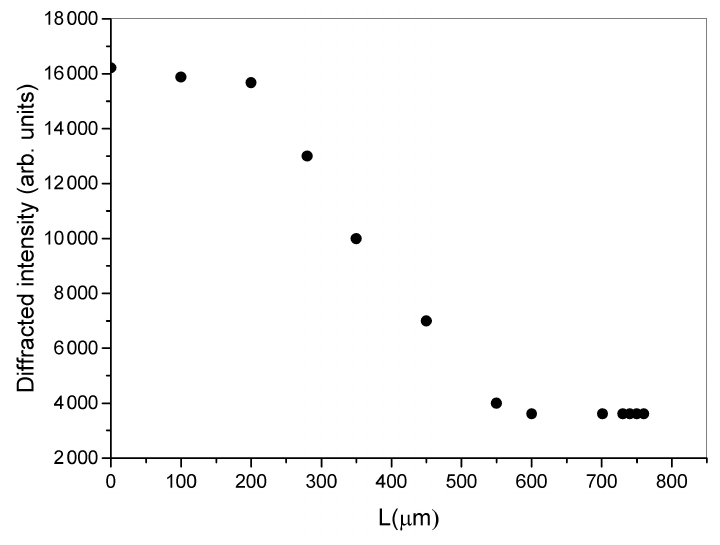
Figure 5. Diffracted intensity as a function of the linear applied compression on the two sides of the